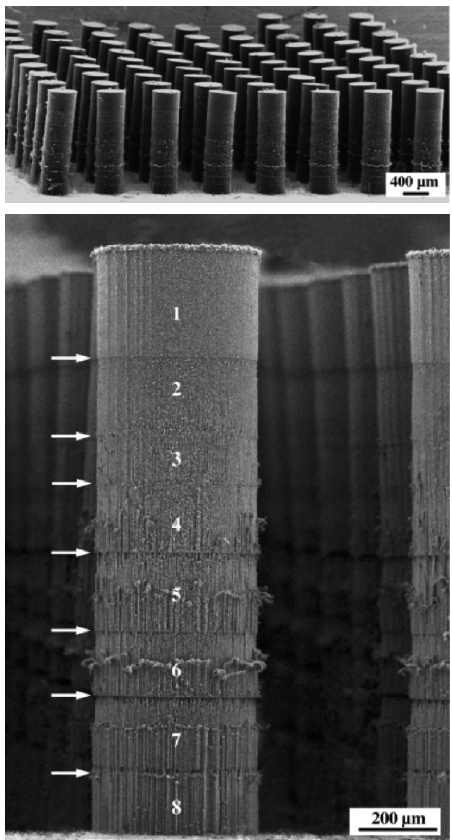
Figure 3. (Top) SEM image showing a two-dimensional array of pillars, each made of eight stacks of vertically aligned nanotube layers. Eight separate chemical vapor deposition (CVD) steps were used to grow the eight stack pillars on pre-patterned SiO Higher-magnification SEM image showing the interfaces indicated by arrows between the separate stacks of nanotubes in a single pillar. The stacks are numbered 1 to 8, corresponding to the first to the eighth stack grown sequentially